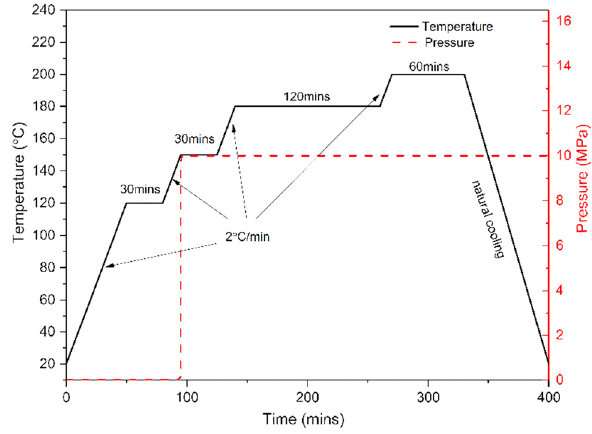
Figure 2: Curing process of C - POSS -